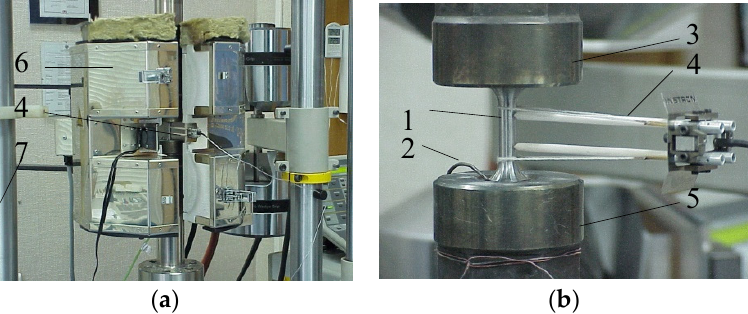
Figure 3. Test stand: ( a ) heating chamber; ( b ) sample in grips. 1—sample, 2—thermocouple, 3—upper grip, 4—extensometer, 5—lower grip, 6—heating chamber, 7—machine frame.